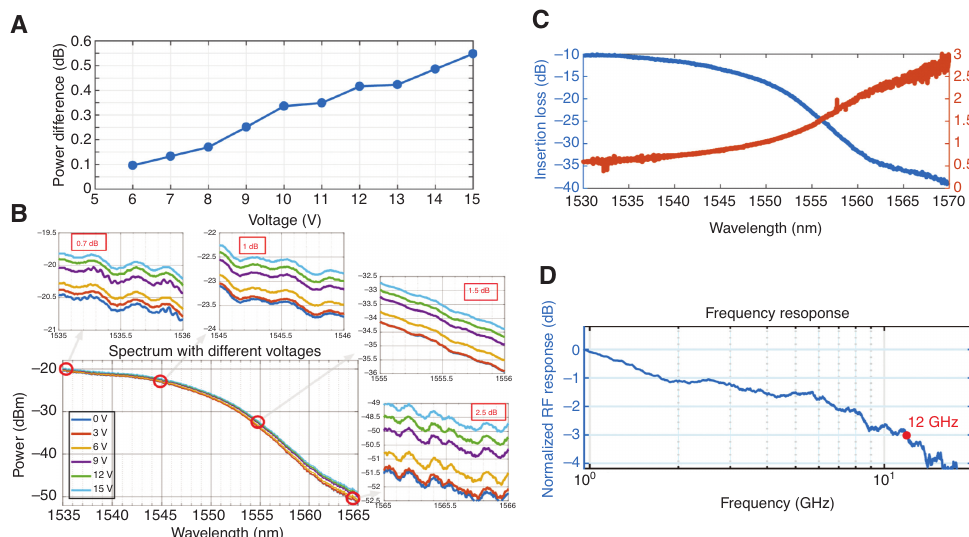
Figure 5: (A) The output power difference for a 10 μ m PhCW modulator with different bias voltages. (B) Spectrum of a 100 μ m PhCW modulator when applying biases (changing from 0 V to 15 V). (C) Wavelength-dependent insertion loss and modulation depth. (D) Frequency response of the modulator with DC of 8 V and RF power of 20